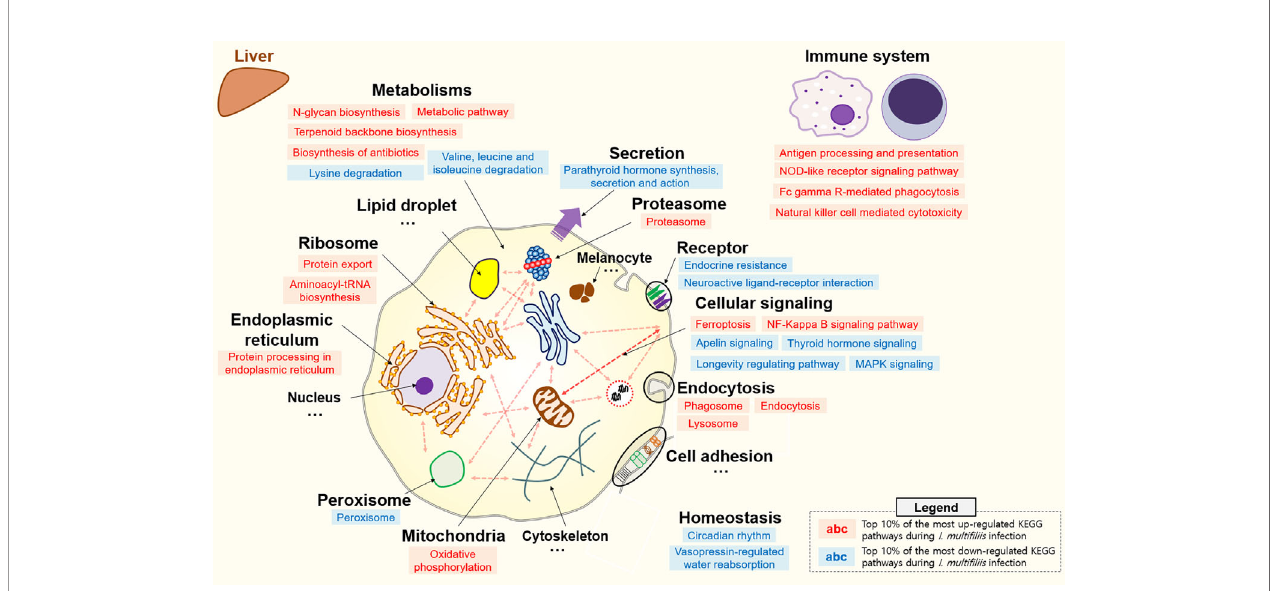
FIGURE 3 | Top 10% enriched KEGG pathways comprised of 18 up- and 12 down-regulated pathways in the liver of rainbow trout during I. multi fi liis infection. The red and blue letters indicate up- and down-regulated KEGG pathways, respectively, during I. multi fi liis infection. More detailed information is available in Table S5 .